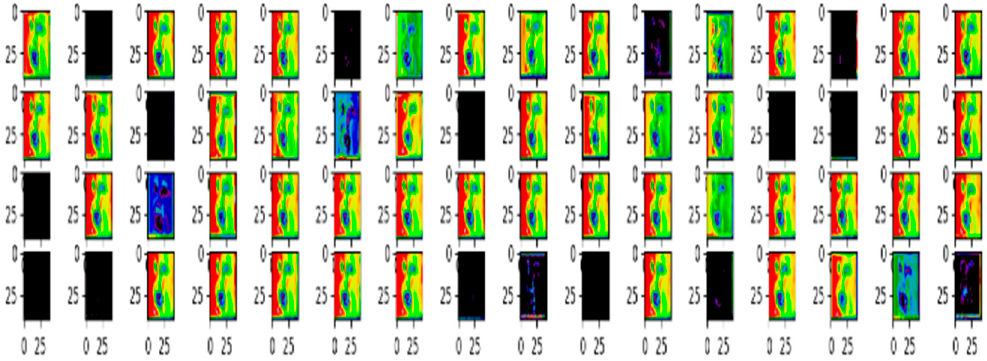
Figure 3. Visualization without ASFF module added.